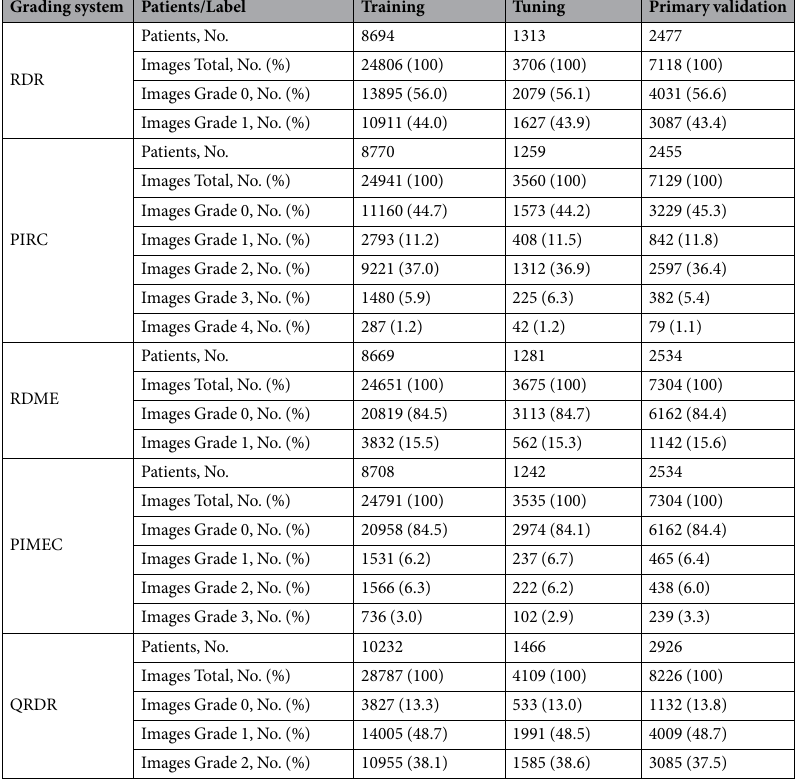
Table 1. Dataset summary. Class distribution shown on as amounts and percentages the dataset divisions between training, tuning, and primary validation used in